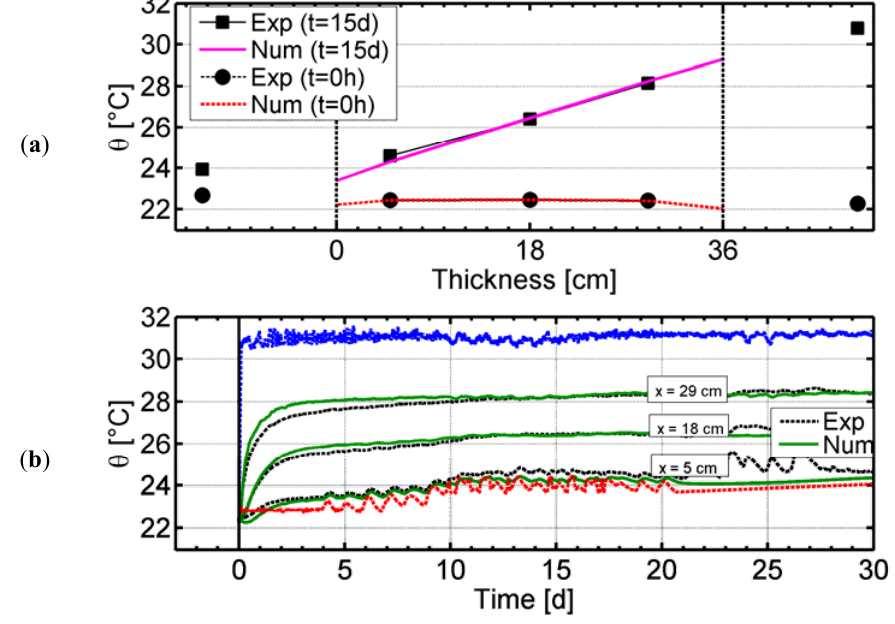
Figure 10. Comparison between experimental (black lines) and simulated (colored lines) temperature of uncoated hemp concrete wall subjected to Experiment 1. Top graph ( a ) shows the spatial response at t = 0 and 15 d; bottom graph ( b ) shows the transient response at x = 5, 18 and